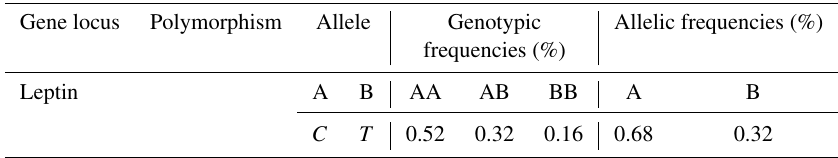
Table 1. Genotypic and allelic frequencies (%) in the studied gene loci.